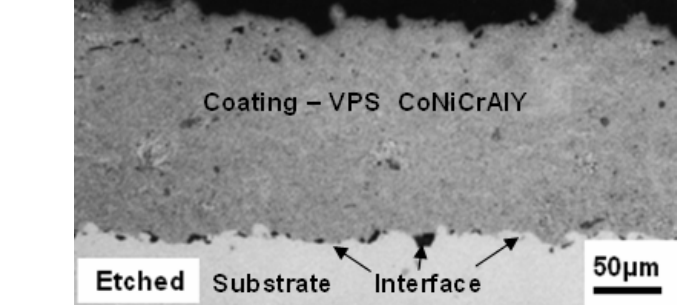
Figure 8 – Etched microstructure of the Co32Ni21Cr8Al0.5Y coating deposited on the sample with a substrate distance of 270 mm Slika 8 – Nagrizena mikrostruktura Co32Ni21Cr8Al0.5Y prevlake deponovane na uzorku sa odstojanjem substrata 270